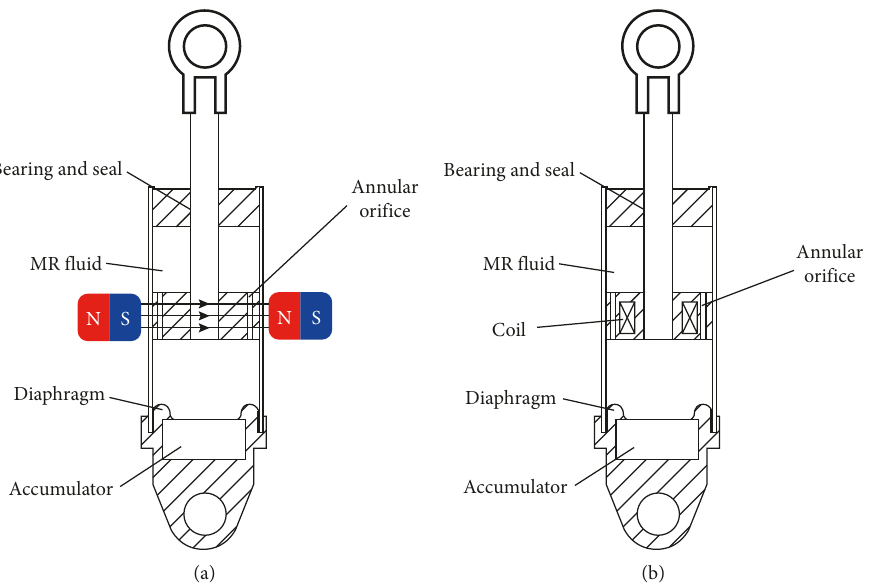
Figure 6: Permanent magnet-based magnetorheological damper (a) compared with active magnetorheological damper